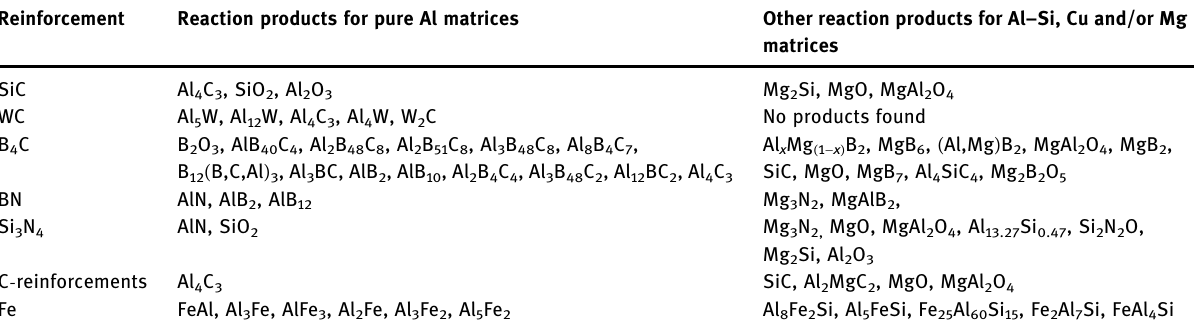
Table 1: Reaction products for di ff erent reinforcements in Al and Al – Si – Cu – Mg matrices